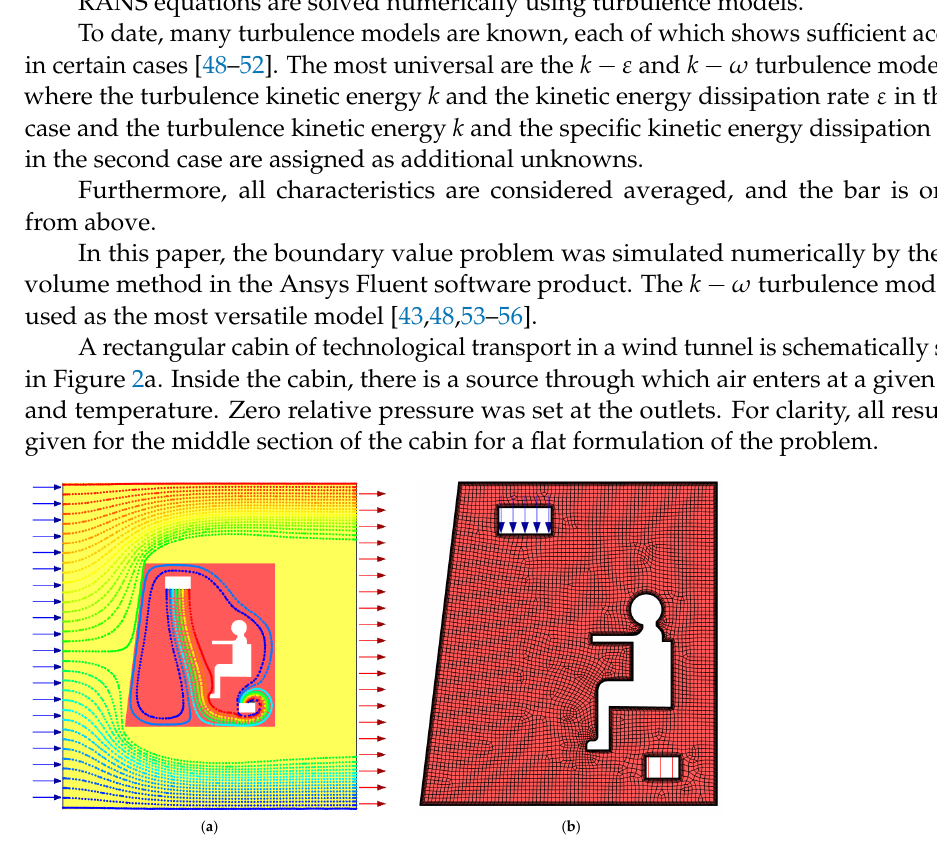
Table 2. Boundary conditions and environment parameters.